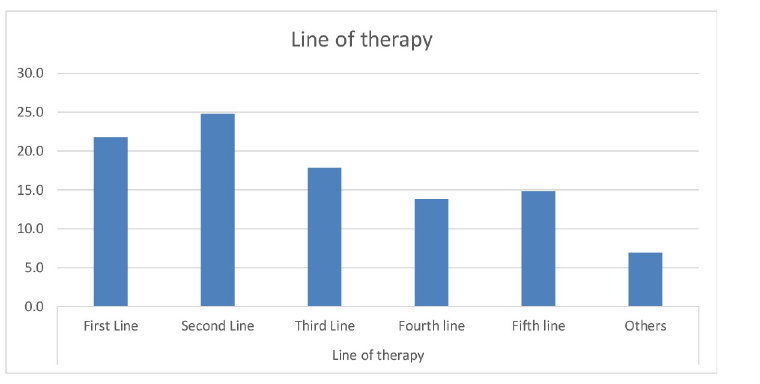
Fig 1. Line of therapy in which CDK 4/6 inhibitor was